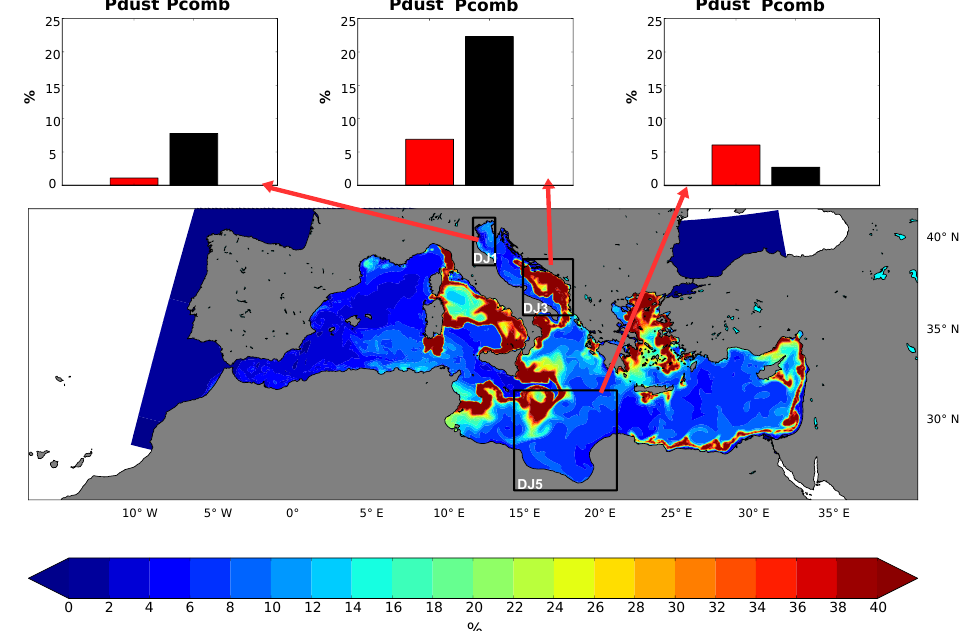
Figure 9. Map of maximal relative effects of total (Pdust + Pcomb) deposition in June 2005 (on a daily basis) on the surface phosphate con- centration (0–10m). The reference PO 4 concentration values are taken from the REF simulation without atmospheric phosphate deposition. Red and black bars represent average relative effects (%) within the framed areas for each P source. The limits of the areas are described in Manca et al. (2004) and Fig. 5. There is no atmospheric deposition modeled in the Marmara and Black seas.